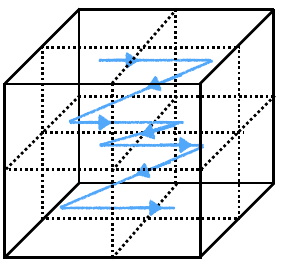
Figure 3. A 3D illustration of morton